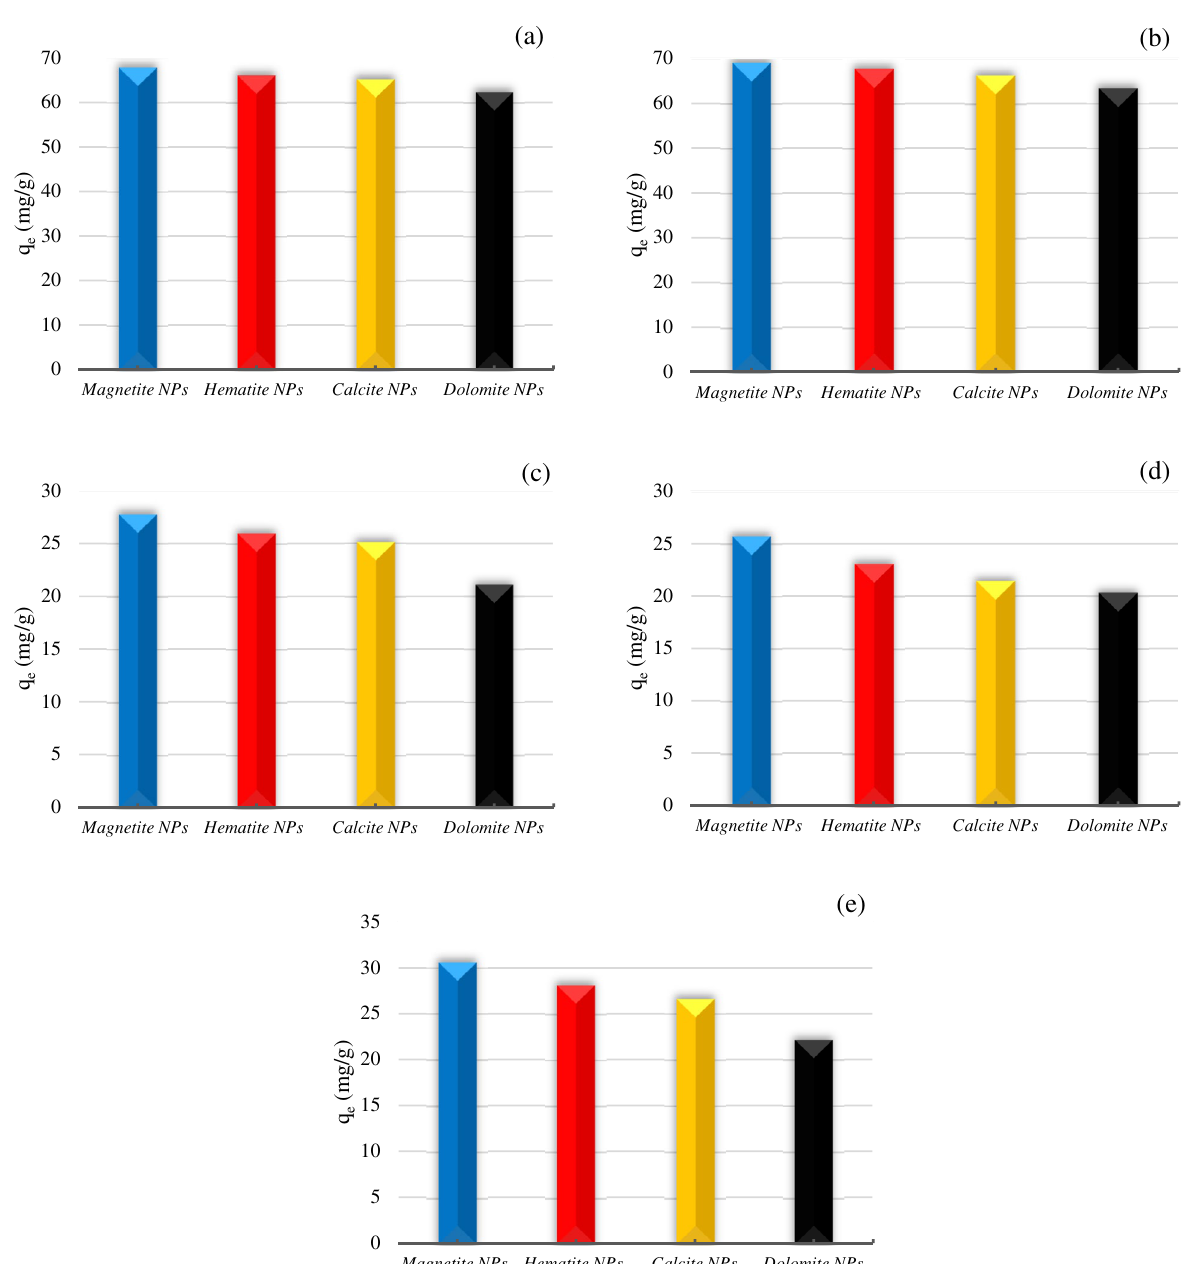
Figure 6. The adsorption amount of each asphaltene ( a ) As-1, ( b ) As-2, ( c ) As-3, ( d ) As-4, ( e ) As-5 onto the magnetite, hematite, calcite, and dolomite NPs at initial concentration of 1000